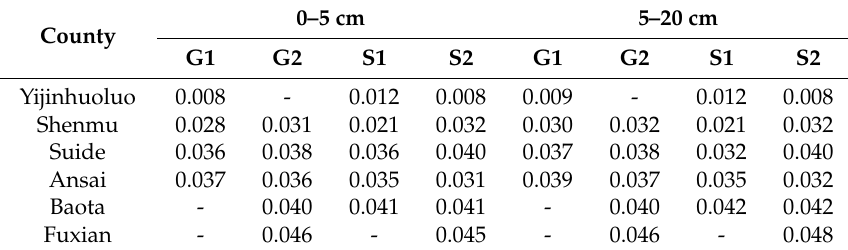
Table 4. The mean value of K at regional scale (t · hm 2 · h/(MJ · mm · hm 2 )). 0–5 cm 5–20 cm County G1 G2 S1 S2 G1 G2 S1 S2 Yijinhuoluo 0.008 - 0.012 0.008 0.009 - 0.012 0.008 0.028 0.031 0.021